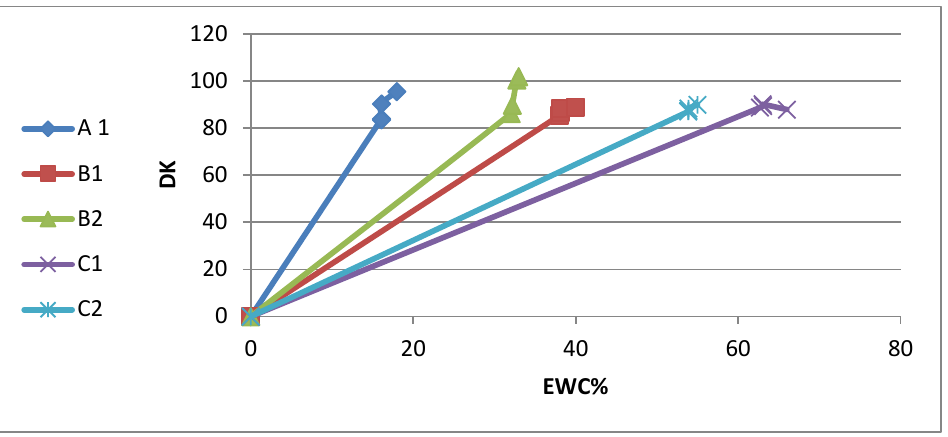
Fig. 12. The correlation between Dk and